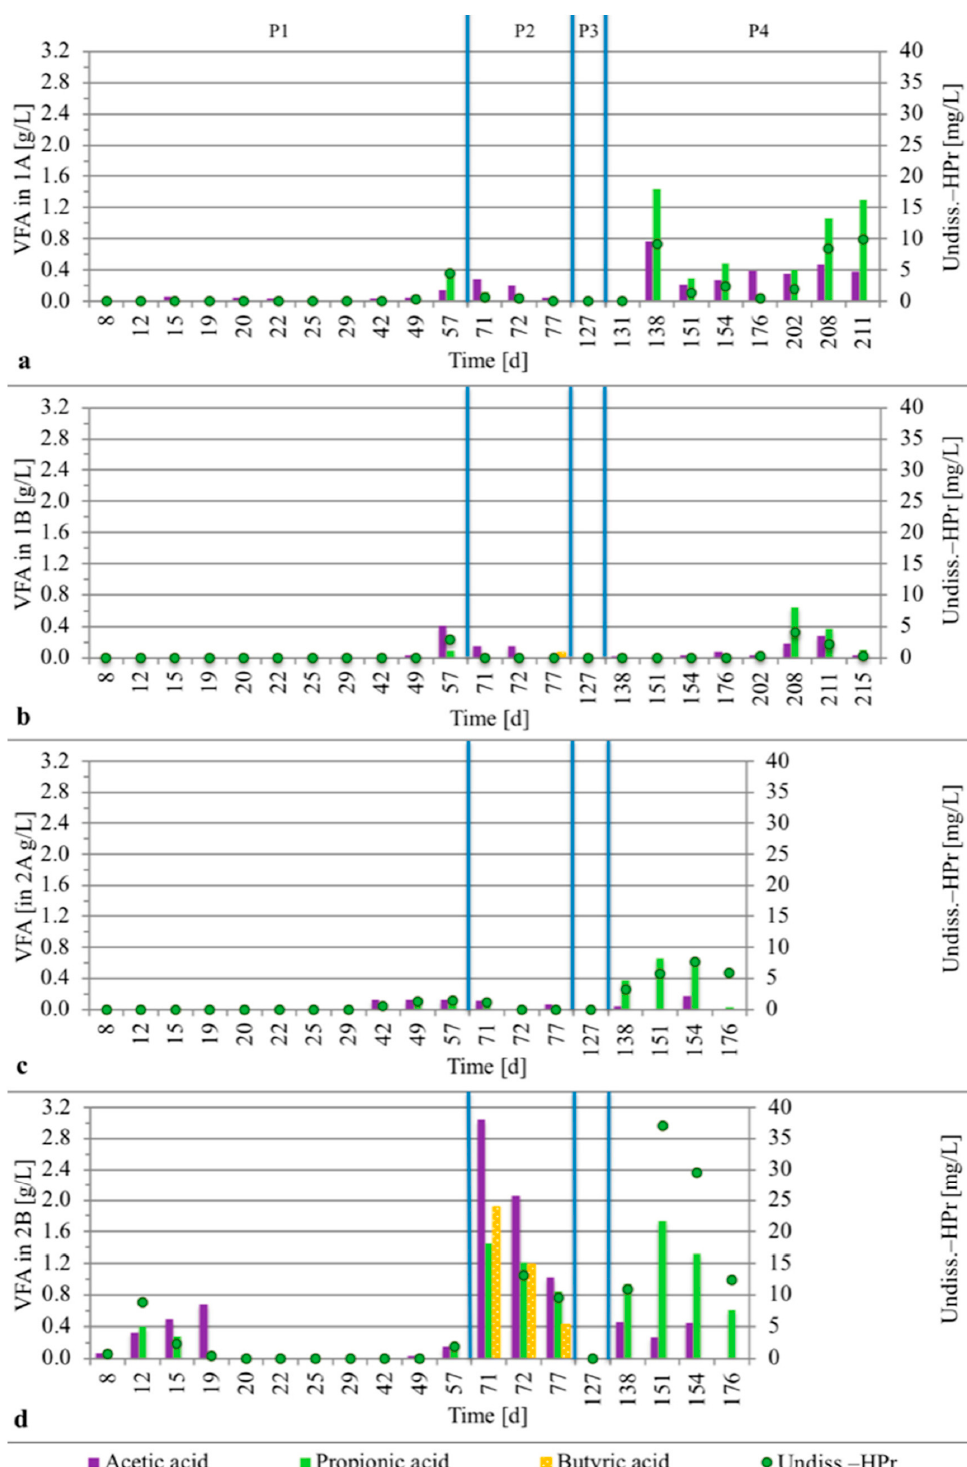
Figure 3. Concentrations of acetic, propionic, and butyric acid (left y-axis) and undissociated propionic acid (right y-axis) in liquids of upflow anaerobic sludge (UASB) reactors: ( a ) 1A; ( b ) 1B; ( c ) 2A; ( d ) 2B. In reactor 2B, the concentration of undissociated propionic acid on day 71 was off the scale (864 mg/L). The blue lines indicate the changes between operating periods 1 to 4 (P1–P4), described in Table 1. Abbreviations: Undiss.-HPr—undissociated propionic acid; VFA—volatile fatty acid; d—days.